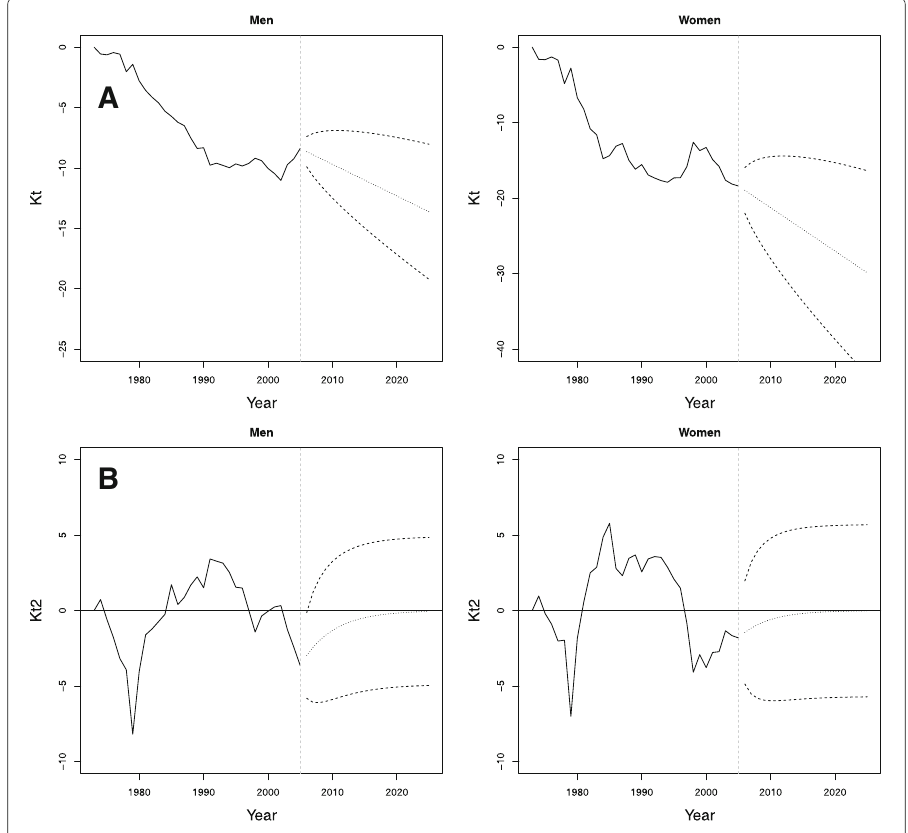
Fig. 8 Prediction of the period indexes of the LC2 models for the period 2006–2025, Colombia. Dashed lines represent central predictions, and dotted lines represent 95% prediction intervals. a k t . b k 2